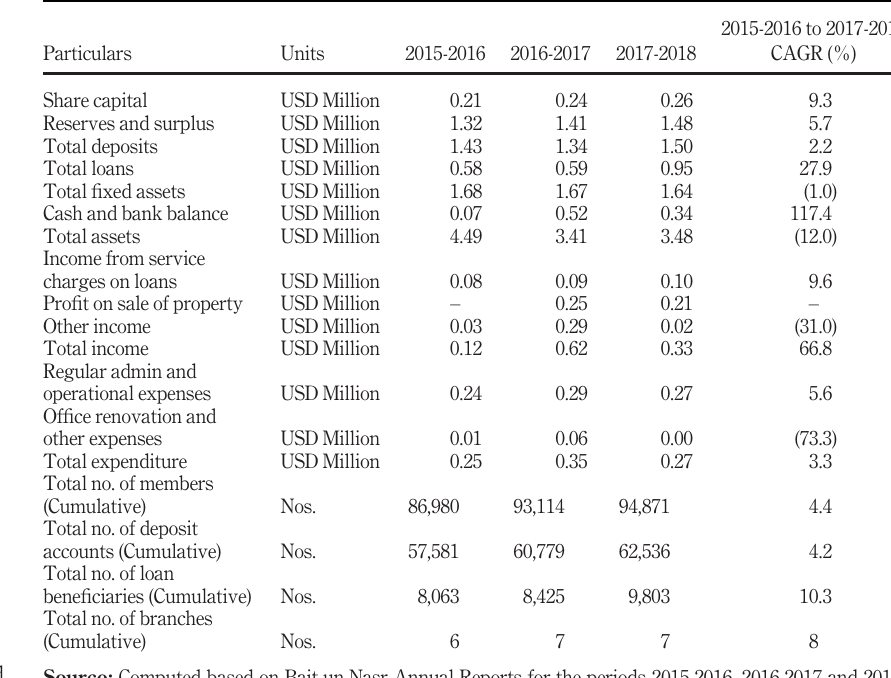
Table I. Pro fi le of Bait-un- Nasr for the